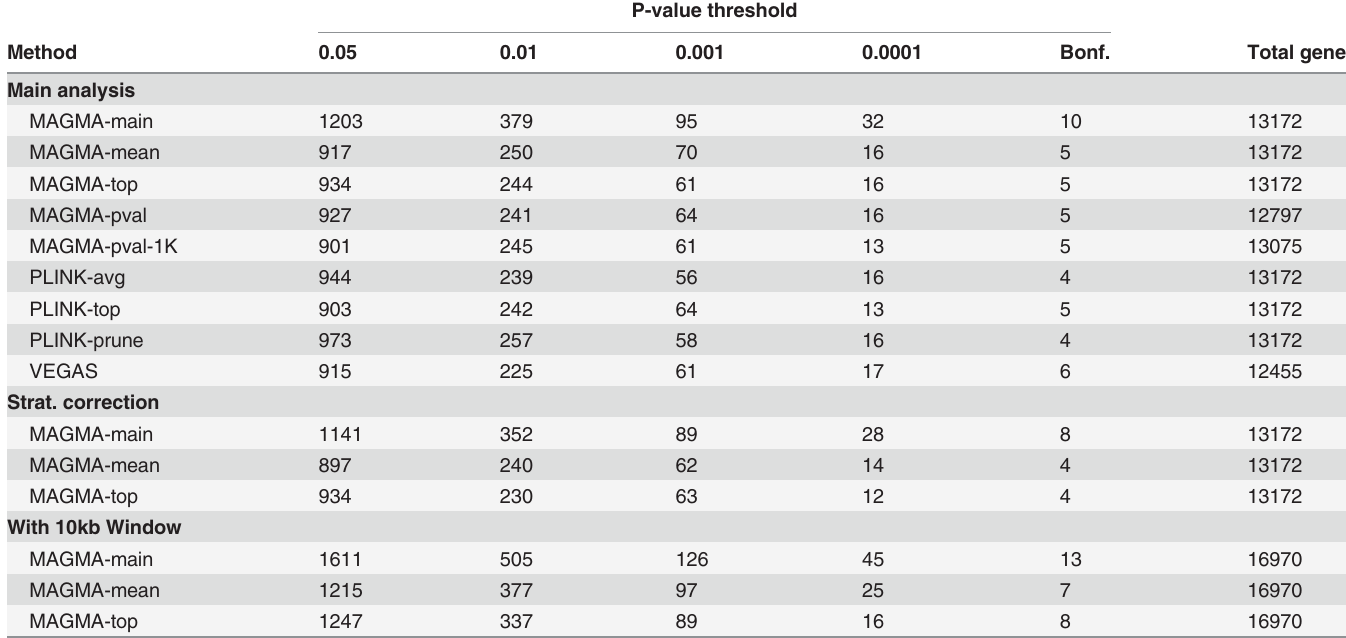
Table 2. Number of significant genes at different p-value thresholds.